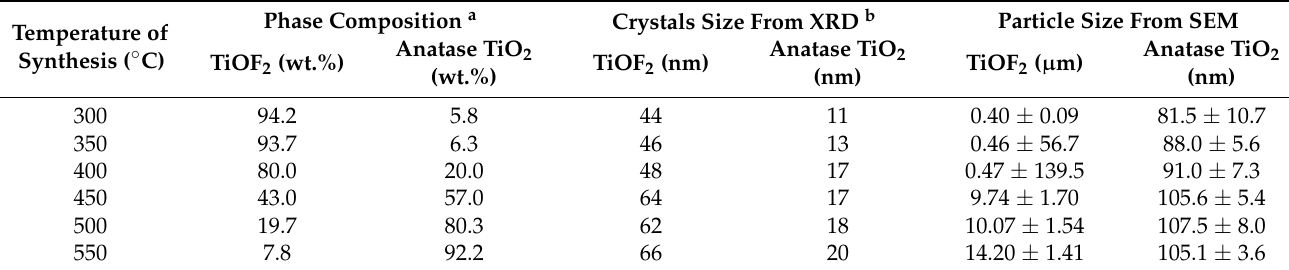
Table 2. Phase composition and crystal size analysis from XRD data in Figure 1 and average particle size from SEM data in Figure 2.